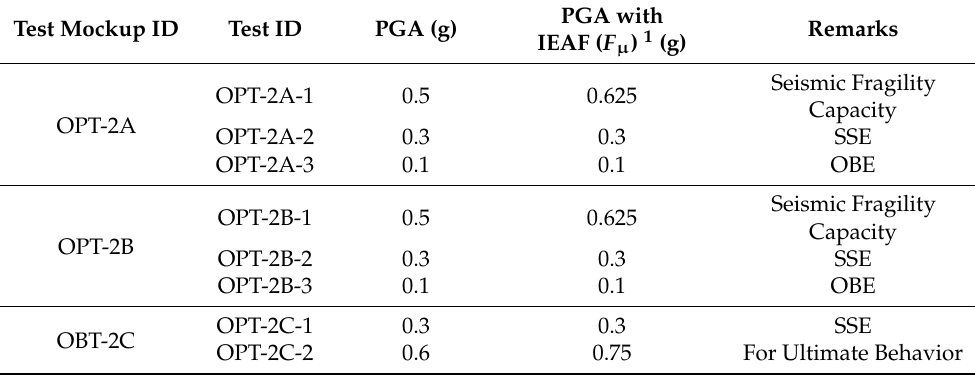
Table 4. Test Table 4. Test Matrix.